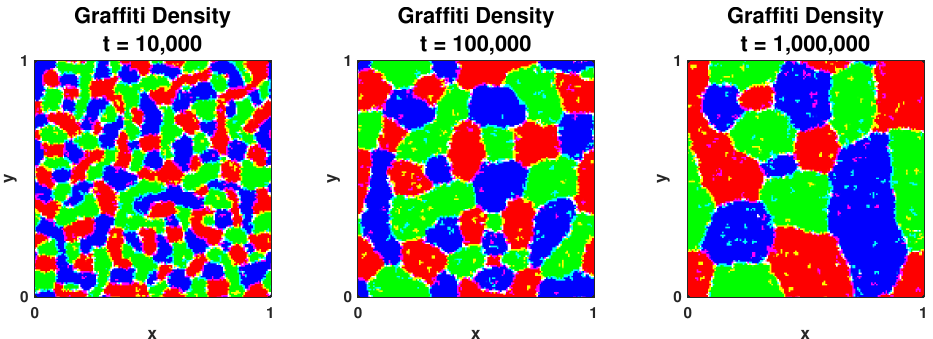
Figure 6. Temporal evolution of the graffiti densities lattice for a segregated state for different grid sizes. Here we have N 1 = N 2 = N 3 = 50,000, with λ = γ = 0.5, β = 3 × 10 − 5 , δ t = 1. First row, L = 50, Second row L = 75, third row L = 100, and fourth row L = 150. We see that the graffiti density is similar as L